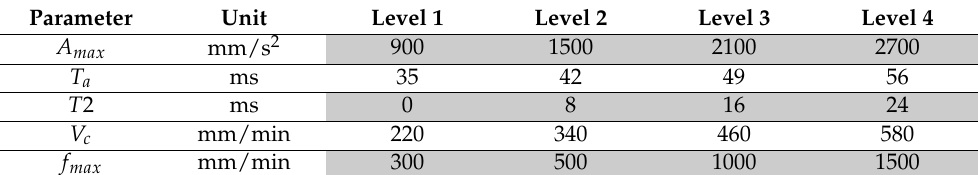
Table 2. Levels of each interpolation parameter.